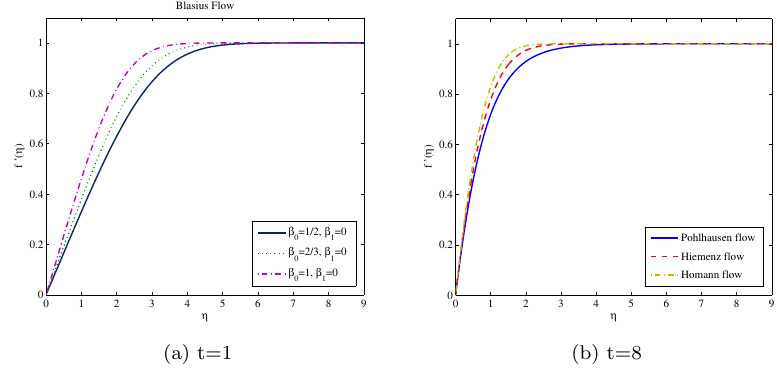
Figure 2. Velocity profile of Falkner-Skan solution for the cases of: Blasius problem β 1 = 0 (left) and Pohlhausen, Hiemenz, and Homann flows β 0 = 0 , 1 , 2 , respectively, with β 1 = 1